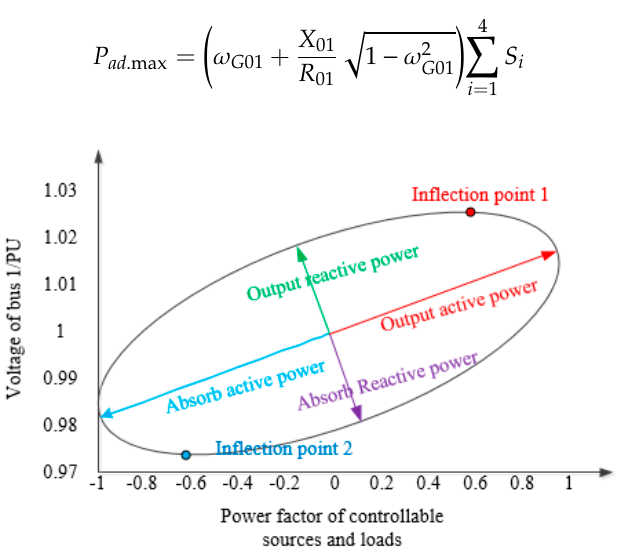
Figure 2. Influence of bus 1 generation and load power factors on bus voltage.